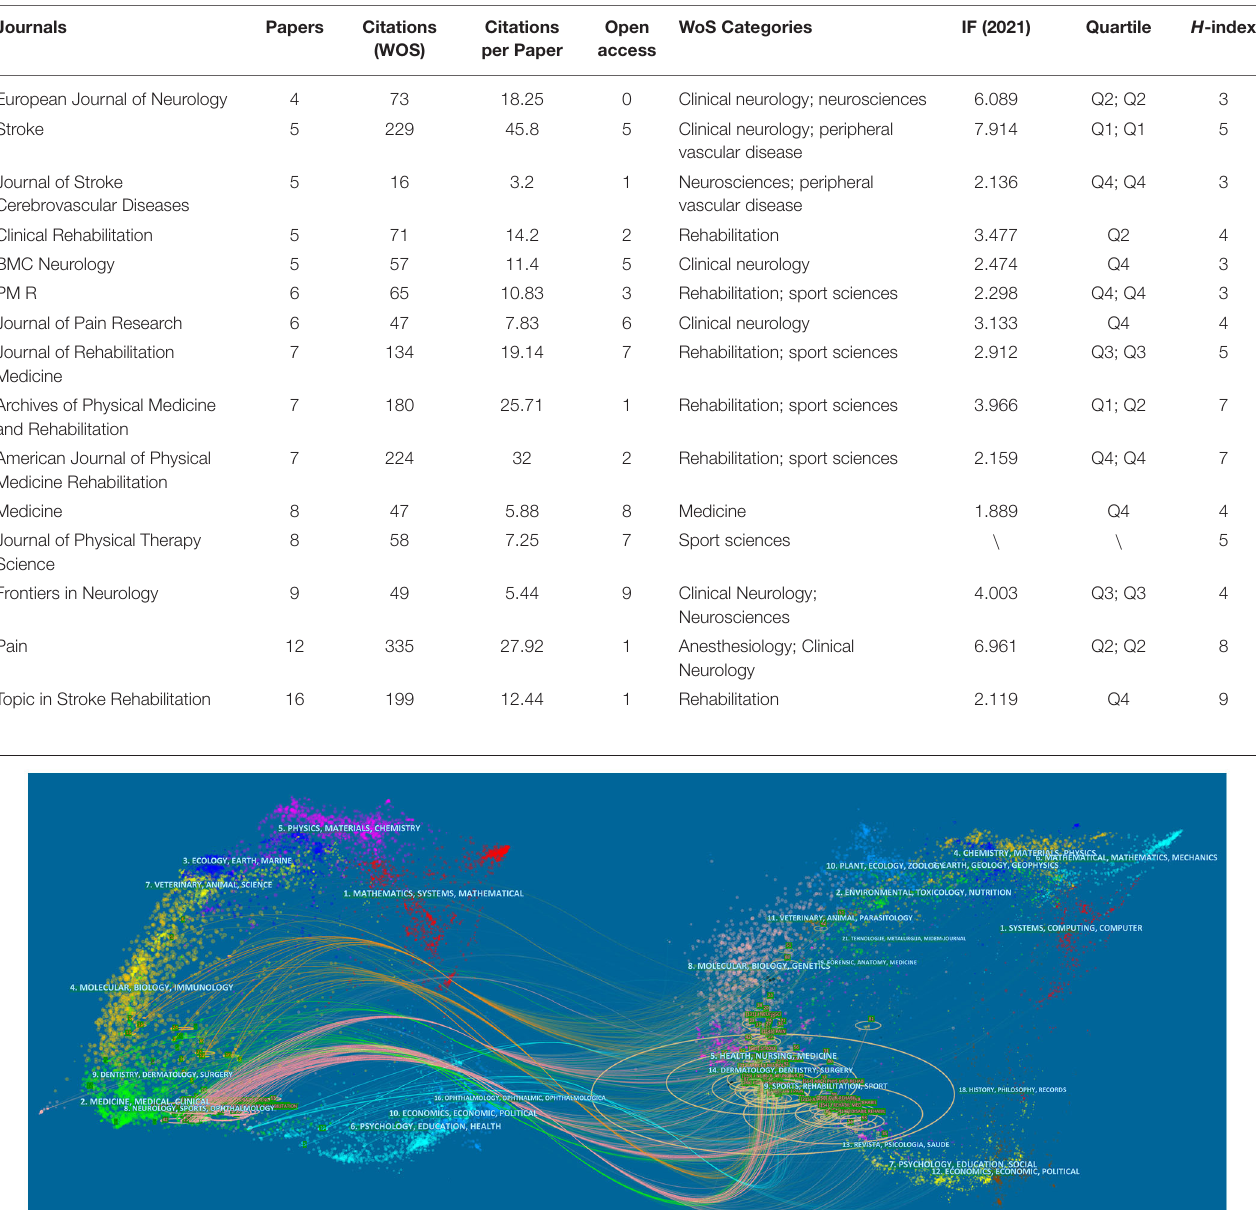
TABLE 1 | The top 15 journals of articles in pain after stroke.